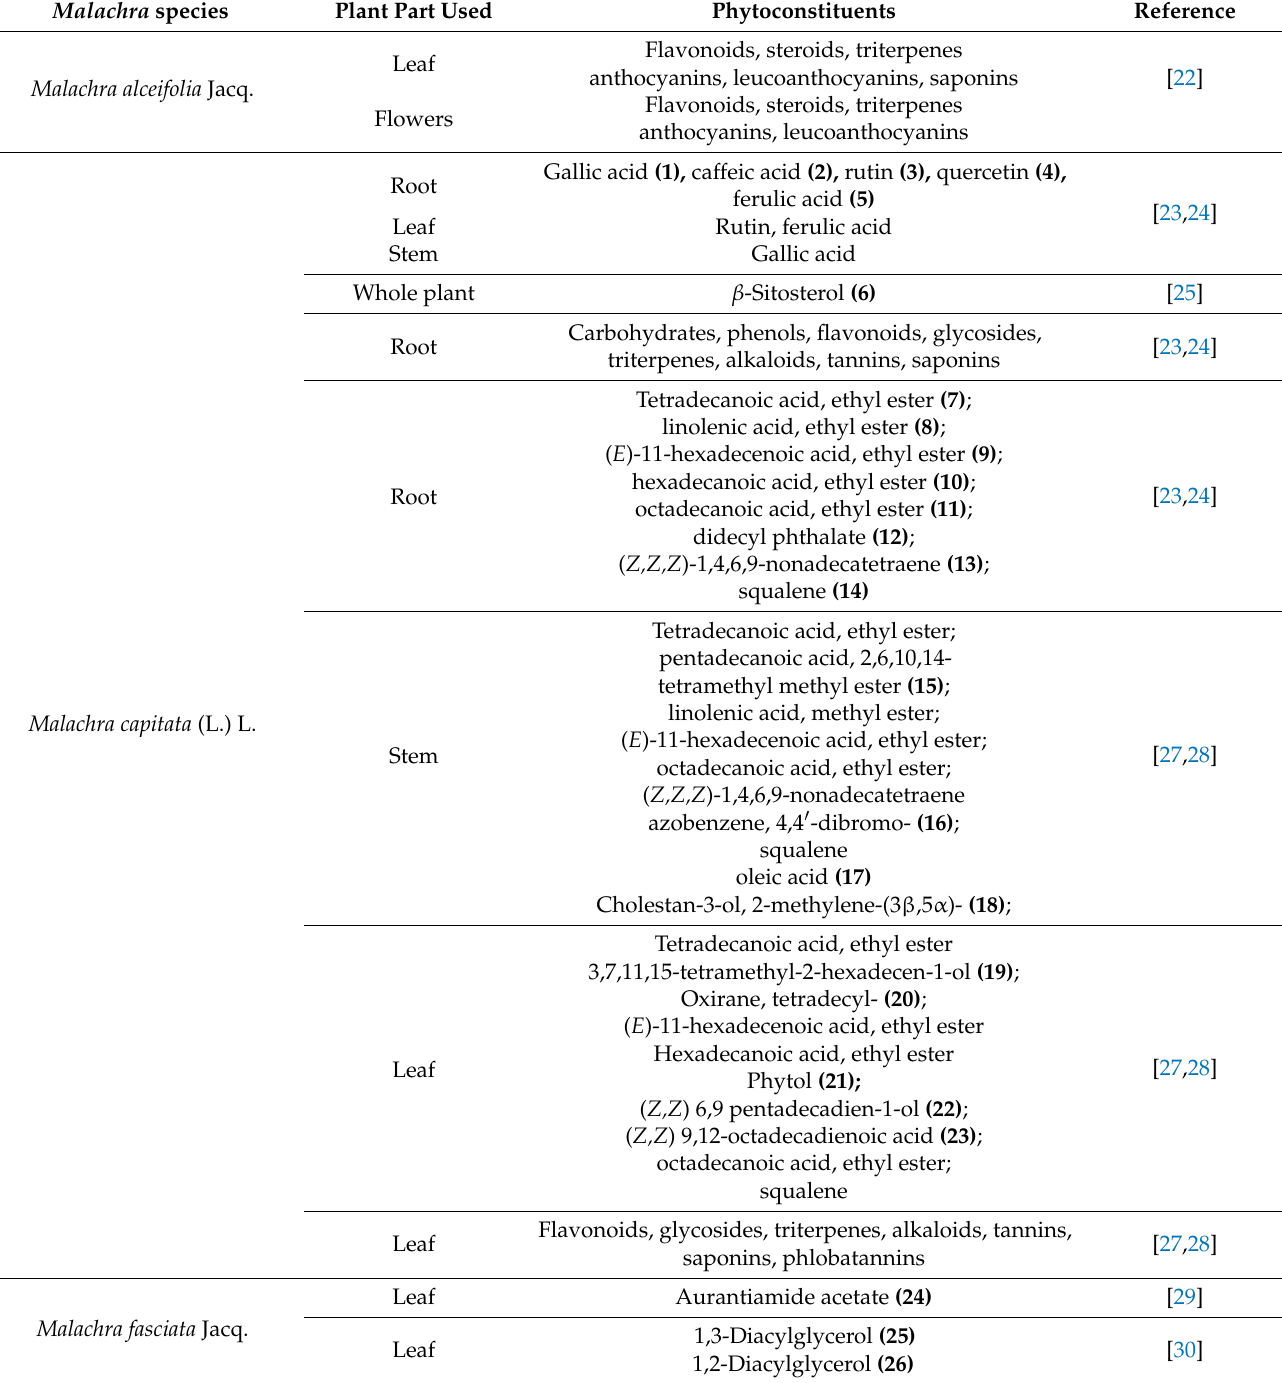
Table 6. Major phytoconstituents identified in species of the genus Malachra